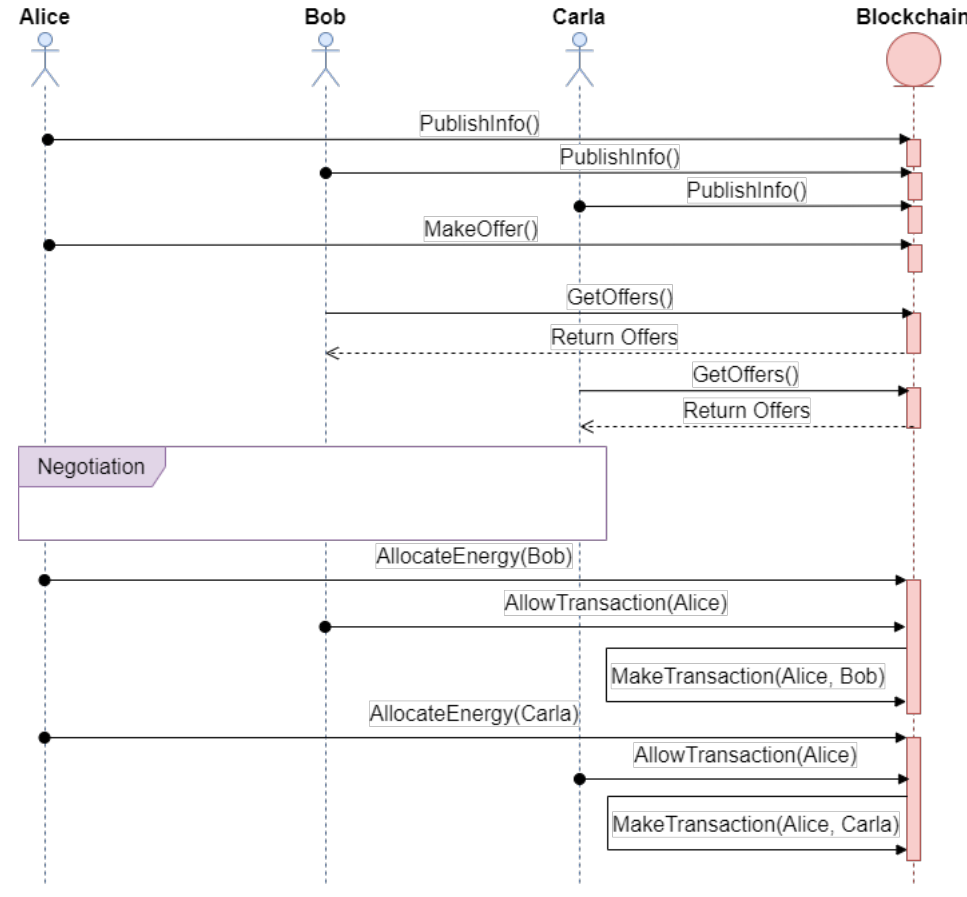
Figure 3. UML diagram of a sample workflow of the proposed